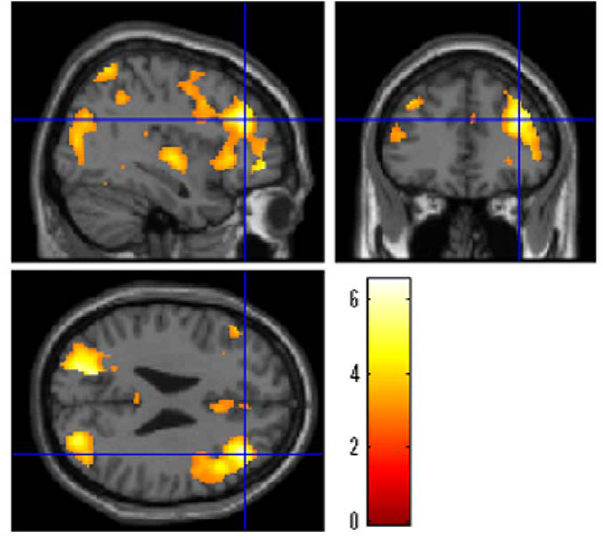
Figure 6. The effect of WM-specific speed on functional activation. A significant result was identified in the right DLPFC. The results are shown with a threshold of P , 0.005, uncorrected for visualization purposes.